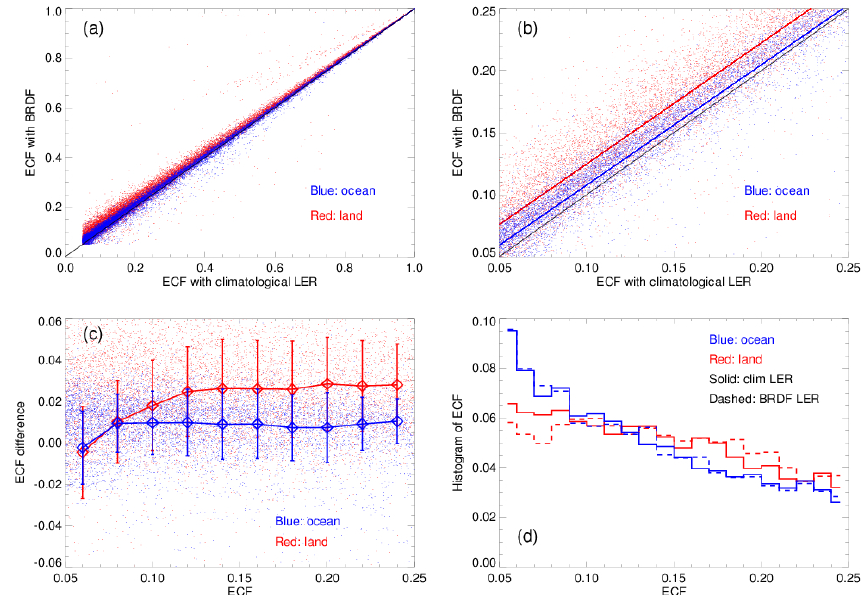
Figure 9. (a) Scatter plot of O 2 –O 2 -retrieved ECFs computed with geometry-dependent LERs vs. climatological LERs, where the 1 : 1 line is in black; (b) similar but for 0 . 05 < ECF < 0 . 25 with linear fits; (c) the mean ECF difference and the standard deviation; (d) normalized histograms of ECF.